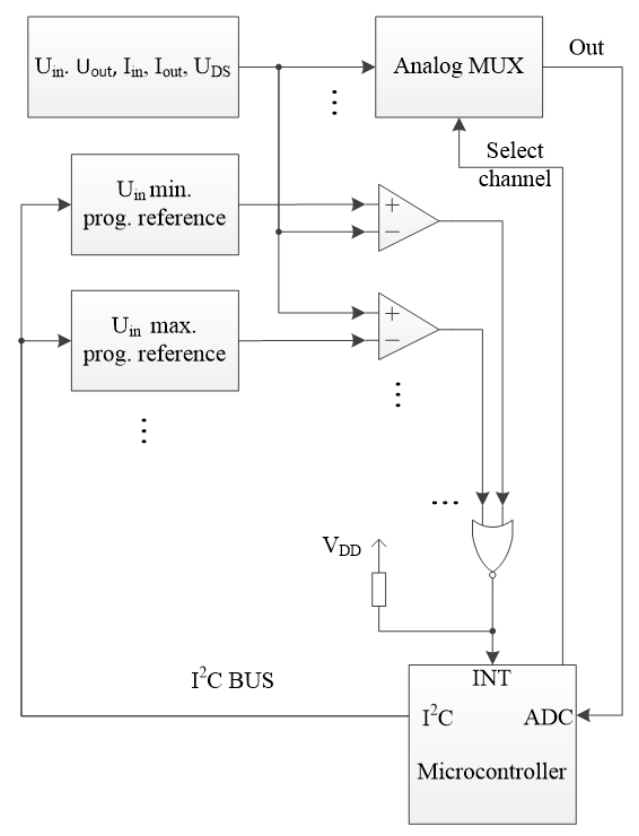
Figure 8. Block diagram of the external interrupt